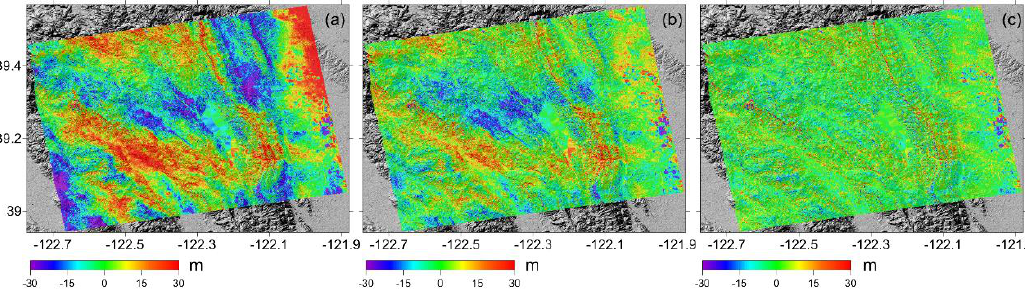
Figure 8. The elevation difference distribution ( a ) without atmospheric correction; ( b ) with Shirzaei’s atmospheric correction method; and ( c ) with MRWCA atmospheric correction.